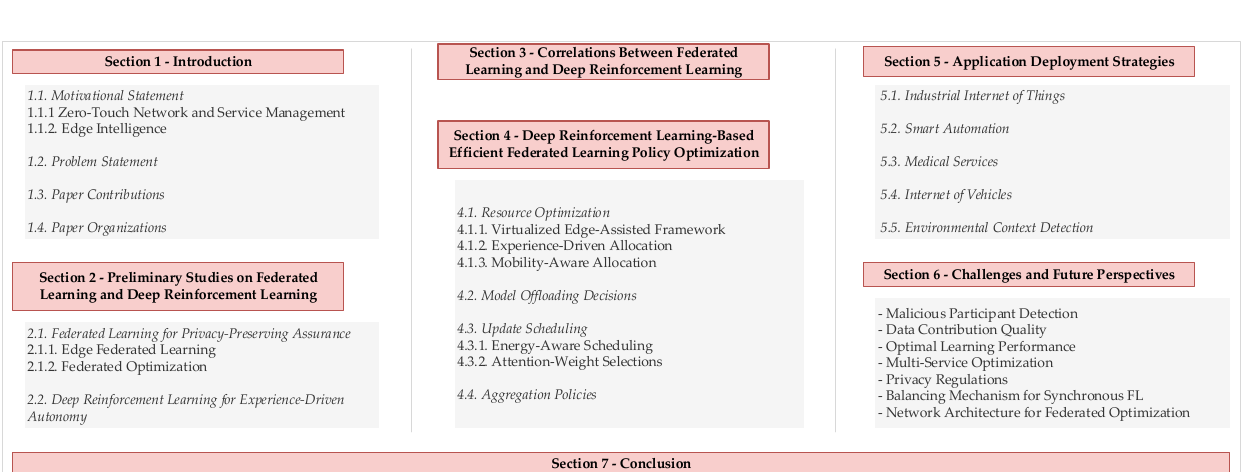
Figure 2. Structure of the paper.